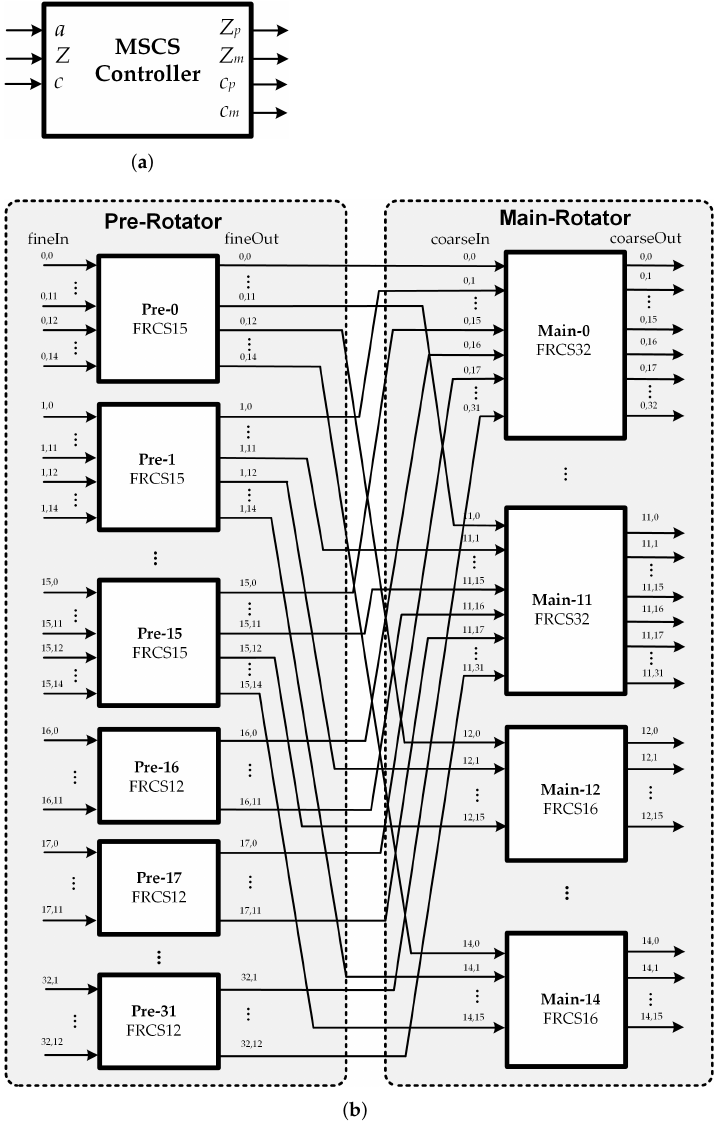
Figure 7. Proposed MSCS network structure for 5G NR LDPC decoders: ( a ) MSCS controller; ( b ) Two stages of the sub-MSCS